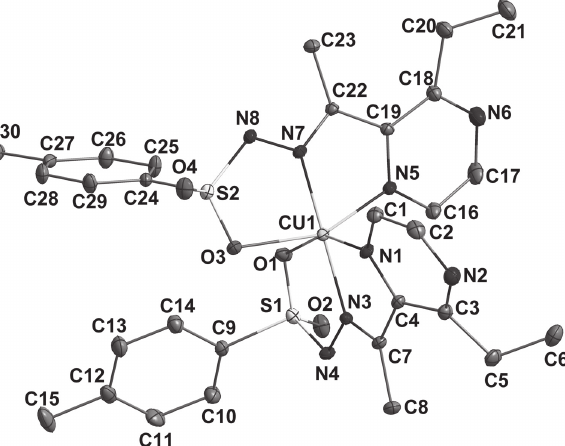
Table 1: Data collection and handling.